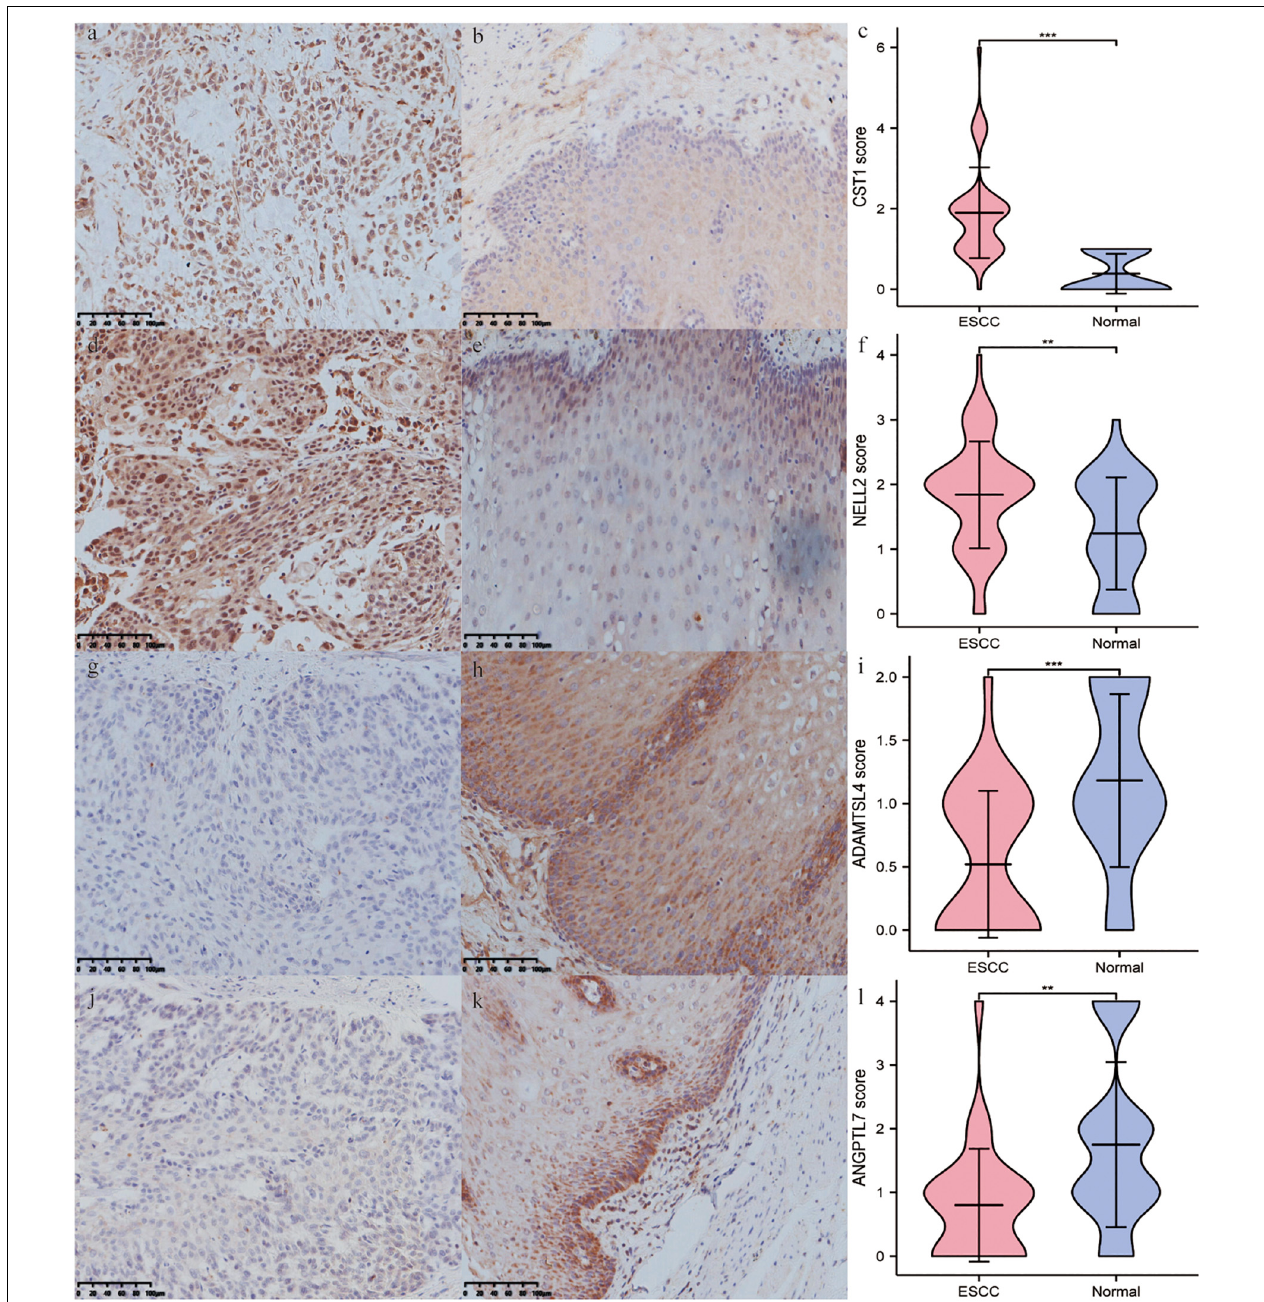
FIGURE 8 | The differential expression of four ECM-related genes in ESCC tissues and adjacent non-tumour tissues detected by immunohistochemistry. The expression levels of CST1 (a–c) and NELL2 (d–f) were higher in ESCC tissues than in adjacent non-tumour tissues. In contrast, the expression levels of ADAMTSL4 (g–i) and ANGPTL7 (j–l) were lower in ESCC tissues (e,g) than in adjacent non-tumour